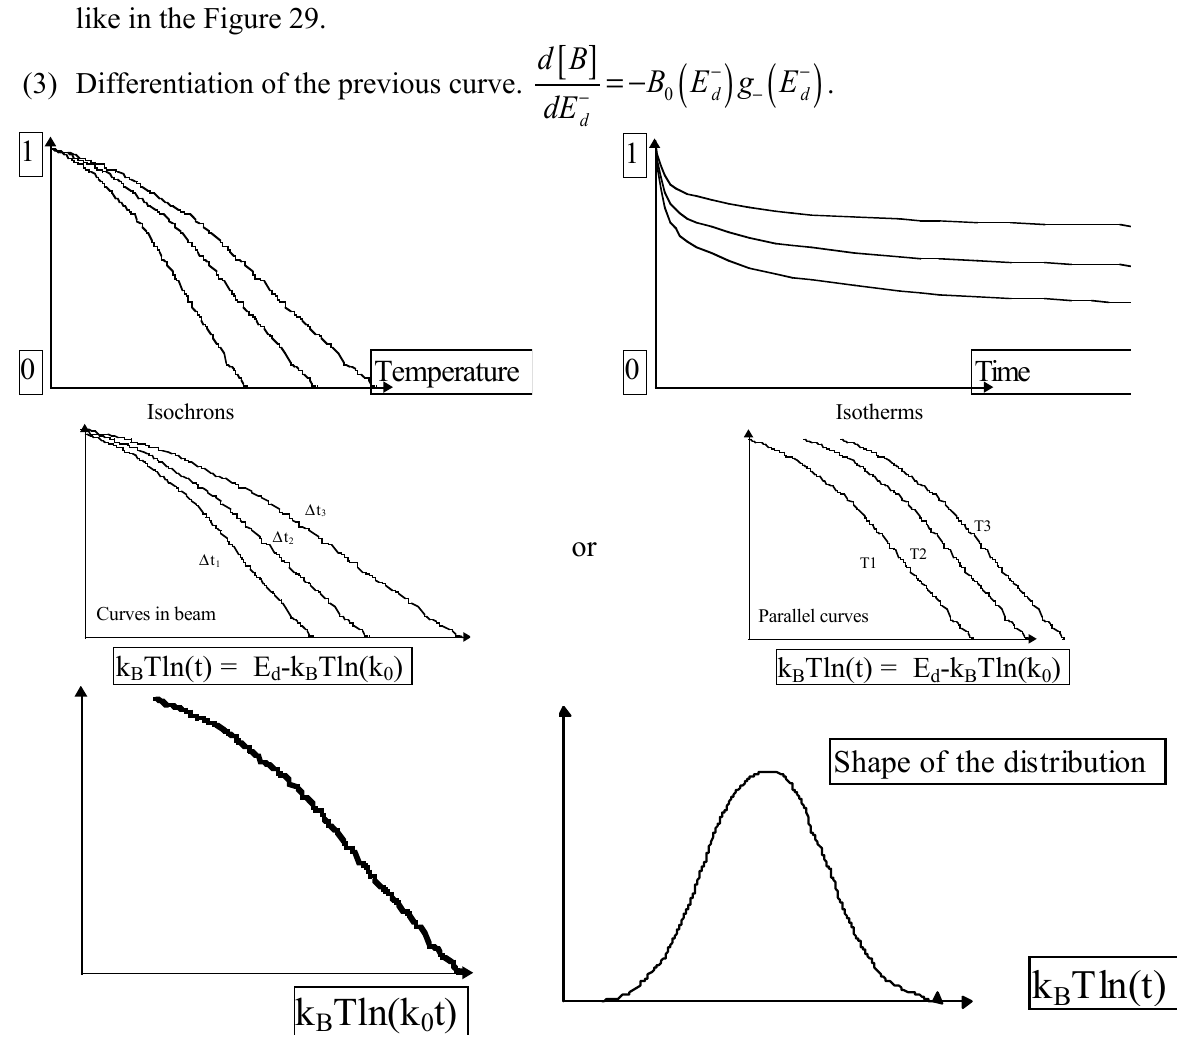
Figure 29. Procedure to obtain k 0 and g ( E